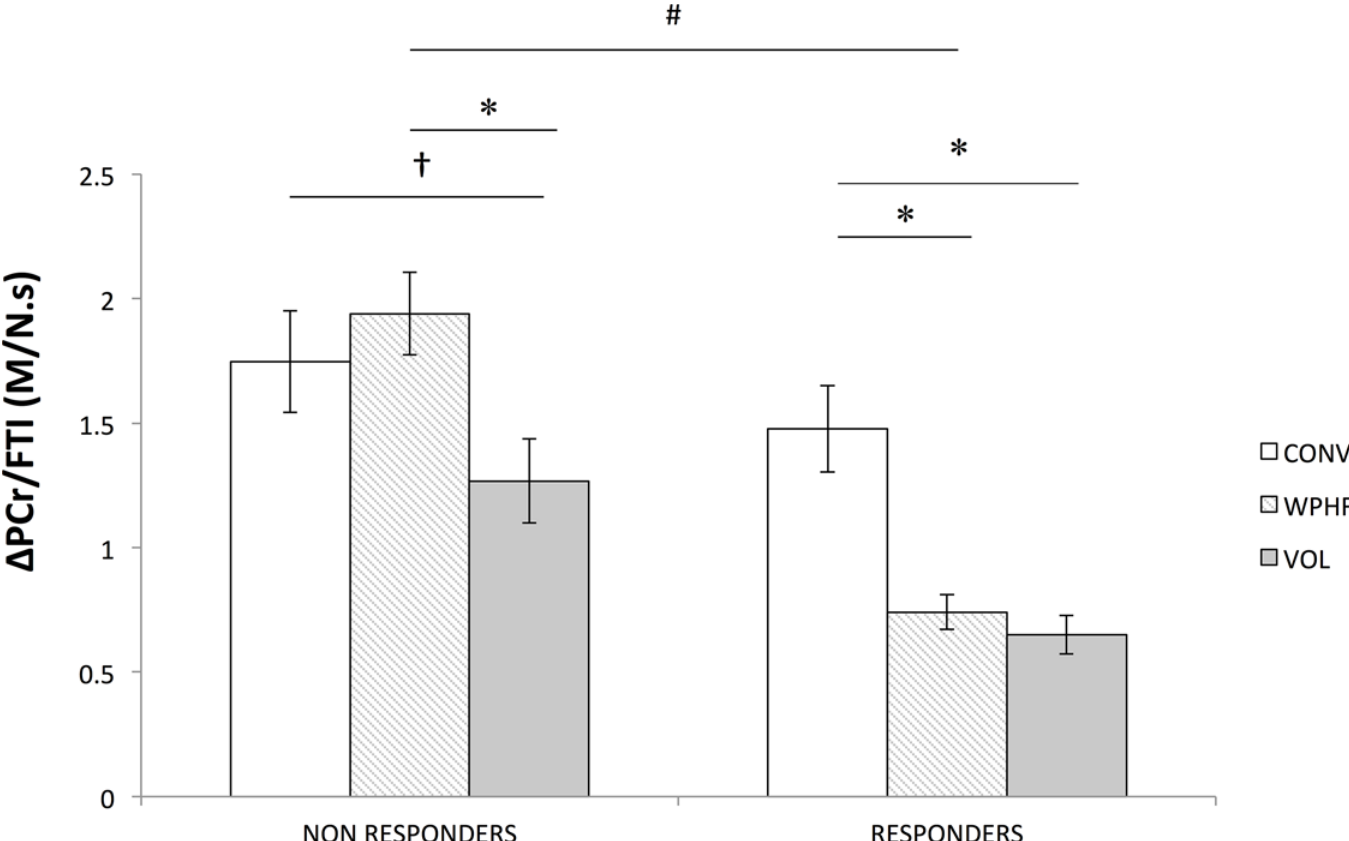
Fig 5. Δ PCr/FTI (in M/N.s) ratio for the non-responders and responders for each protocol. * Significantly different within groups for P < 0.05, † non- significant tendency (P = 0.07), # WPHF significantly different between groups for P < 0.05. Results are presented as means ±